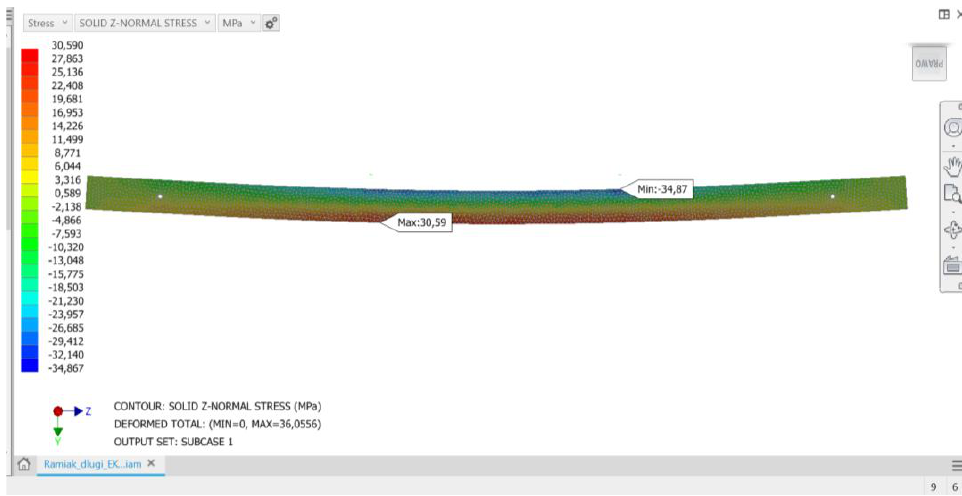
Figure 5. Mesh (computational) model of A-frame made of solid wood material with distribution of normal stress map.